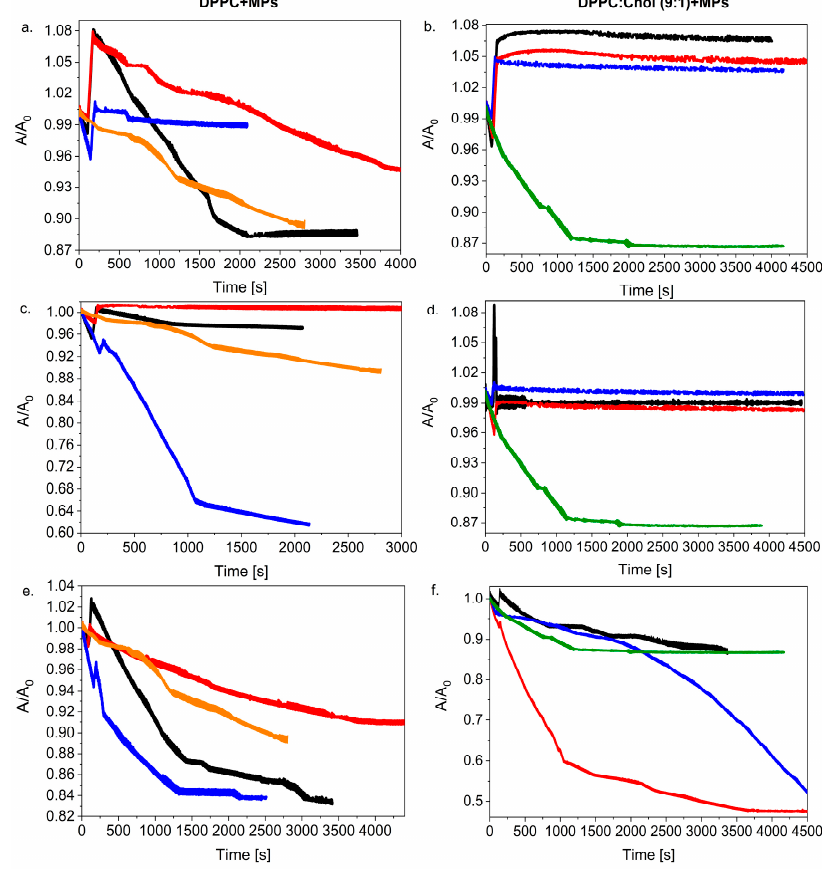
Figure 4. Relative area–time curves for various concentrations of silica particles (0.1%, 1.0% and 2.5%) injected on DPPC or DPPC:Chol (9:1) with volume of 20 µL ( a , b ), 10 µL ( c , d ) or 5 µL ( e , f ) (black line—MPs 2.5%; red line—MPs—1.0%; blue line—MPs—0.1%; orange line—DPPC (without MPs); green line—DPPC:Chol (9:1) (without MPs)).